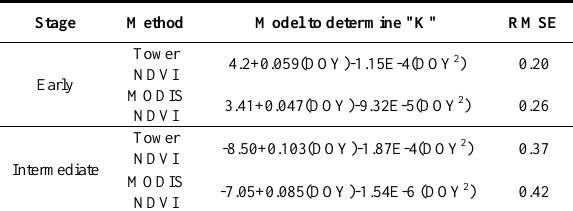
Table 2. Evaluation of the different methods to derive LAI in Santa Rosa National Park,